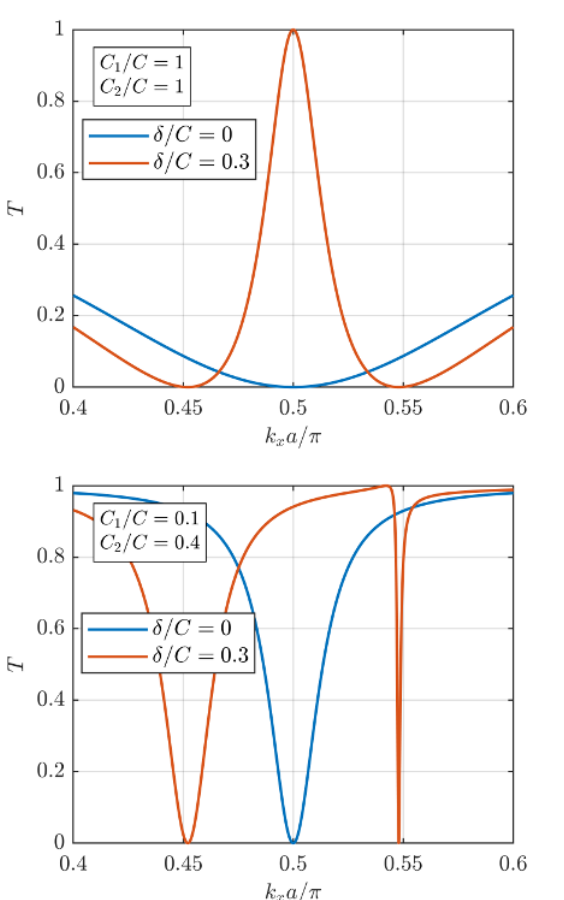
Figure 4. The transmittance spectra T for the parameters of Fig. 3 corresponding to the system with preserved (blue line) and bro- ken (red line)